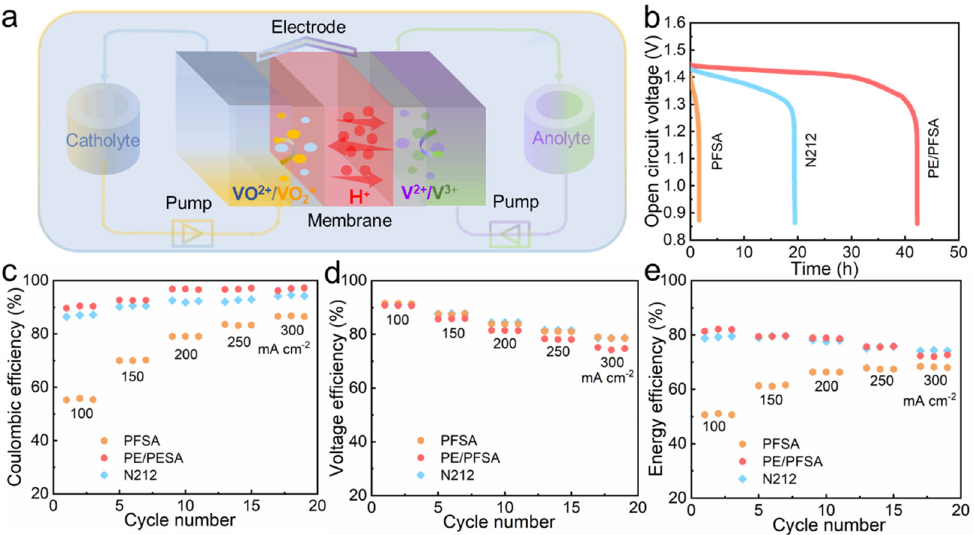
Figure 5. ( a ) Schematic illustration of operating principle for a VFB; ( b ) OCV curves over time at 100 mA cm − 2 ; and ( c – e ) CE, VE, and EE of VFBs with pure PFSA, PE/PFSA composite, and Nafion212 membranes at current densities from 100 to 300 mA cm − 2 .